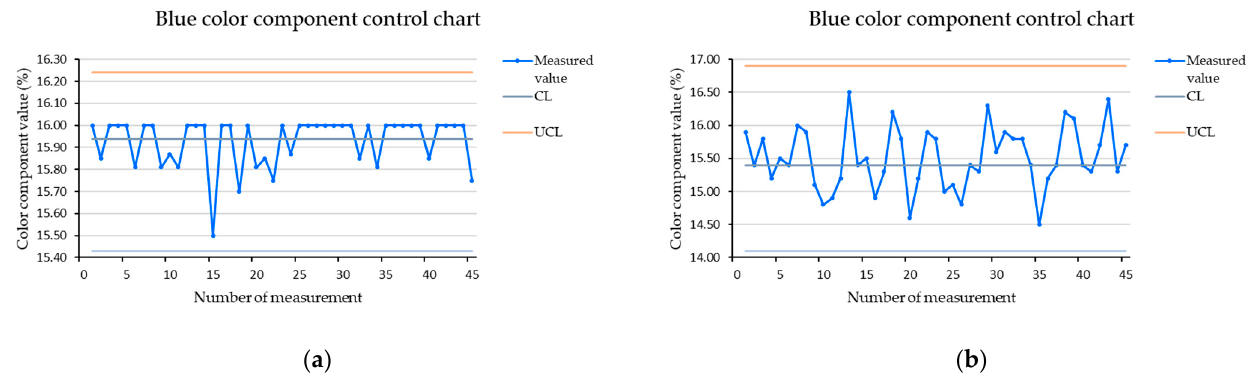
Figure 7. Blue color component control chart for a brown cube measured in the dark, at a scanning distance of 15 mm; ( a ) stopped cube; ( b ) cube in motion. ( a ) stopped cube; ( b ) cube in